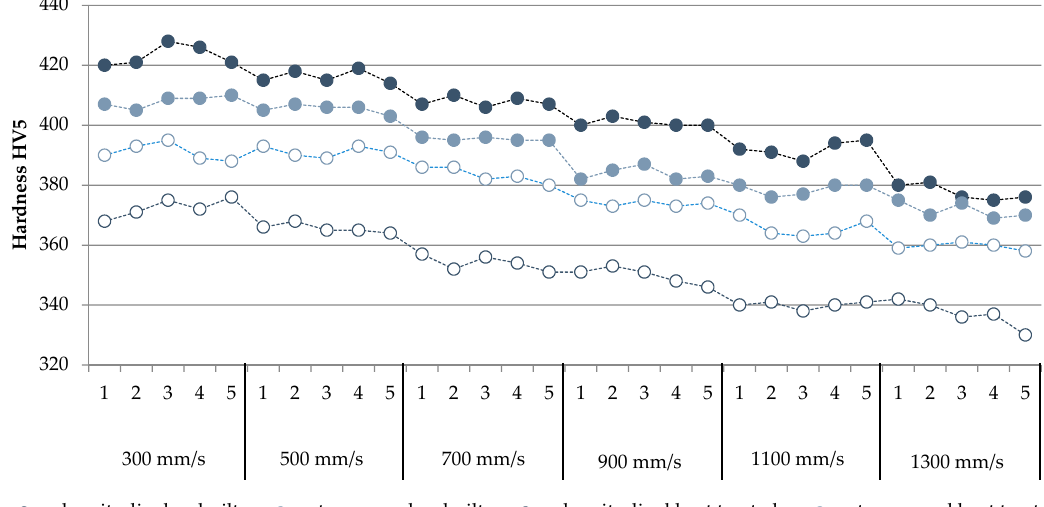
Figure 9. Comparison of series and samples hardness.